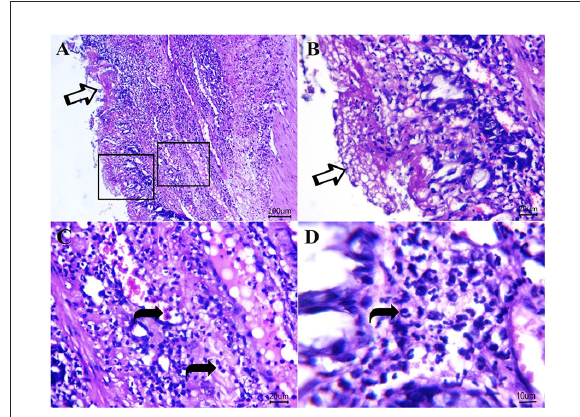
FIGURE7 Photomicrograph of H&E sections from cat idiopathic megacolon that had ≥ 6 months duration of constipation/obstipation showing moderate to severe degenerative changes. (A, B) The diphtheritic membrane is replaced by most mucosal layers (arrows). Scale bar 100 and 20 µ m, respectively. (C, D) Neutrophils (curved arrows) and proteinaceous exudates within lamina propria and submucosa. Scale bar 20 and 10 µ m, respectively.